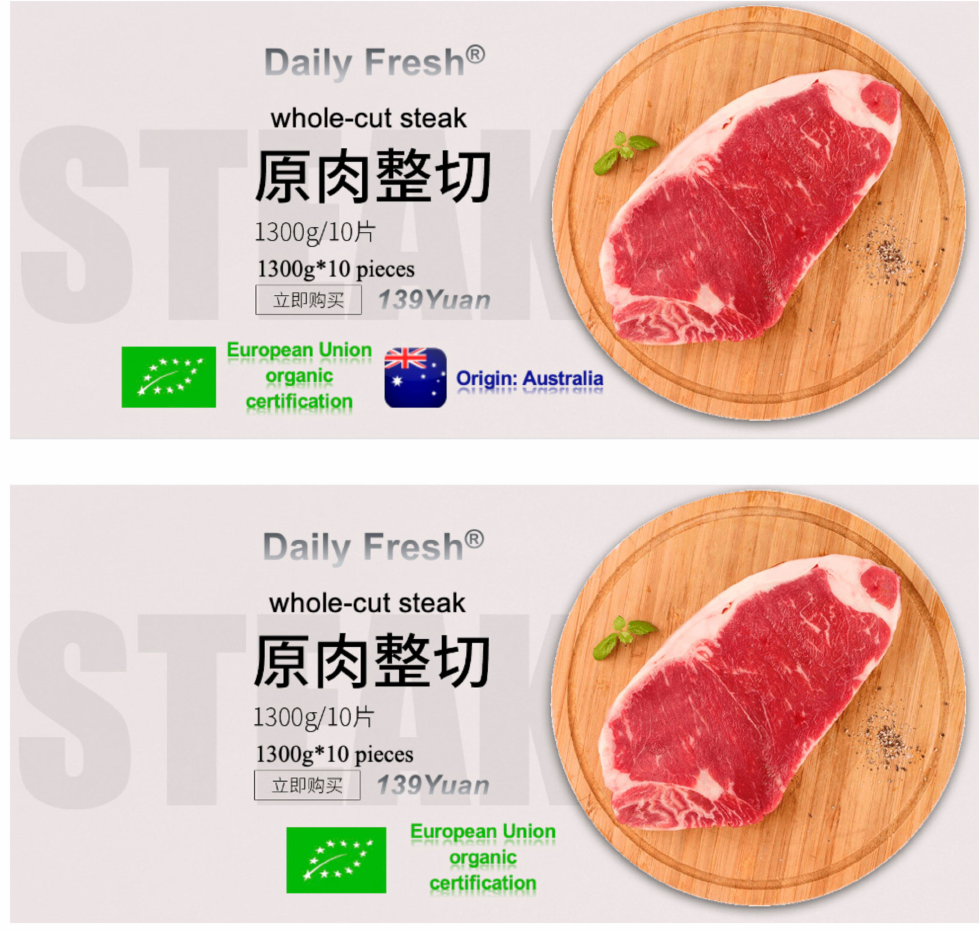
Figure 7. Labels in study 3.